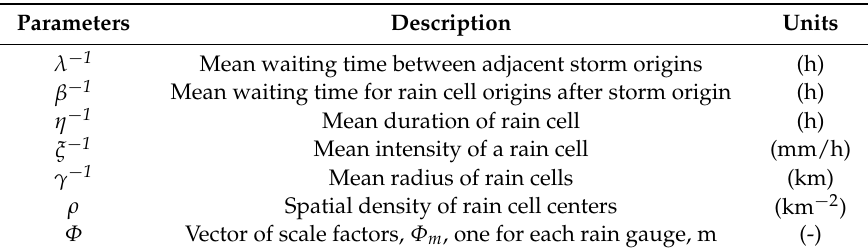
Table 2. RainSim V3 calibration